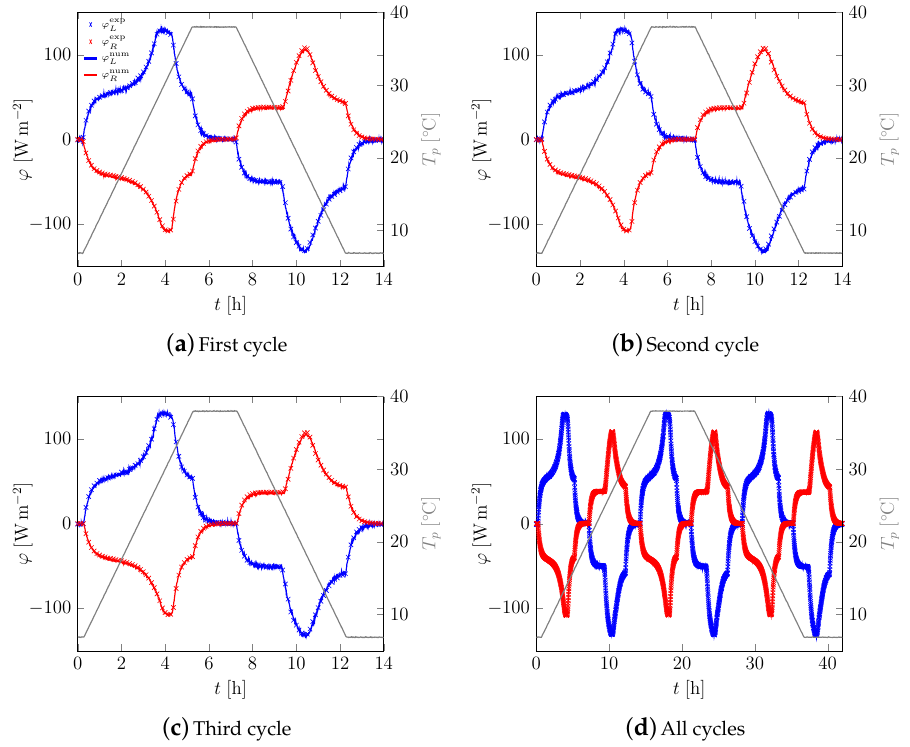
Figure A7. 19.2% w -PCM mortar: comparisons of the experimental fluxes with the numerical ones after identification for the 5h heating/cooling ramp